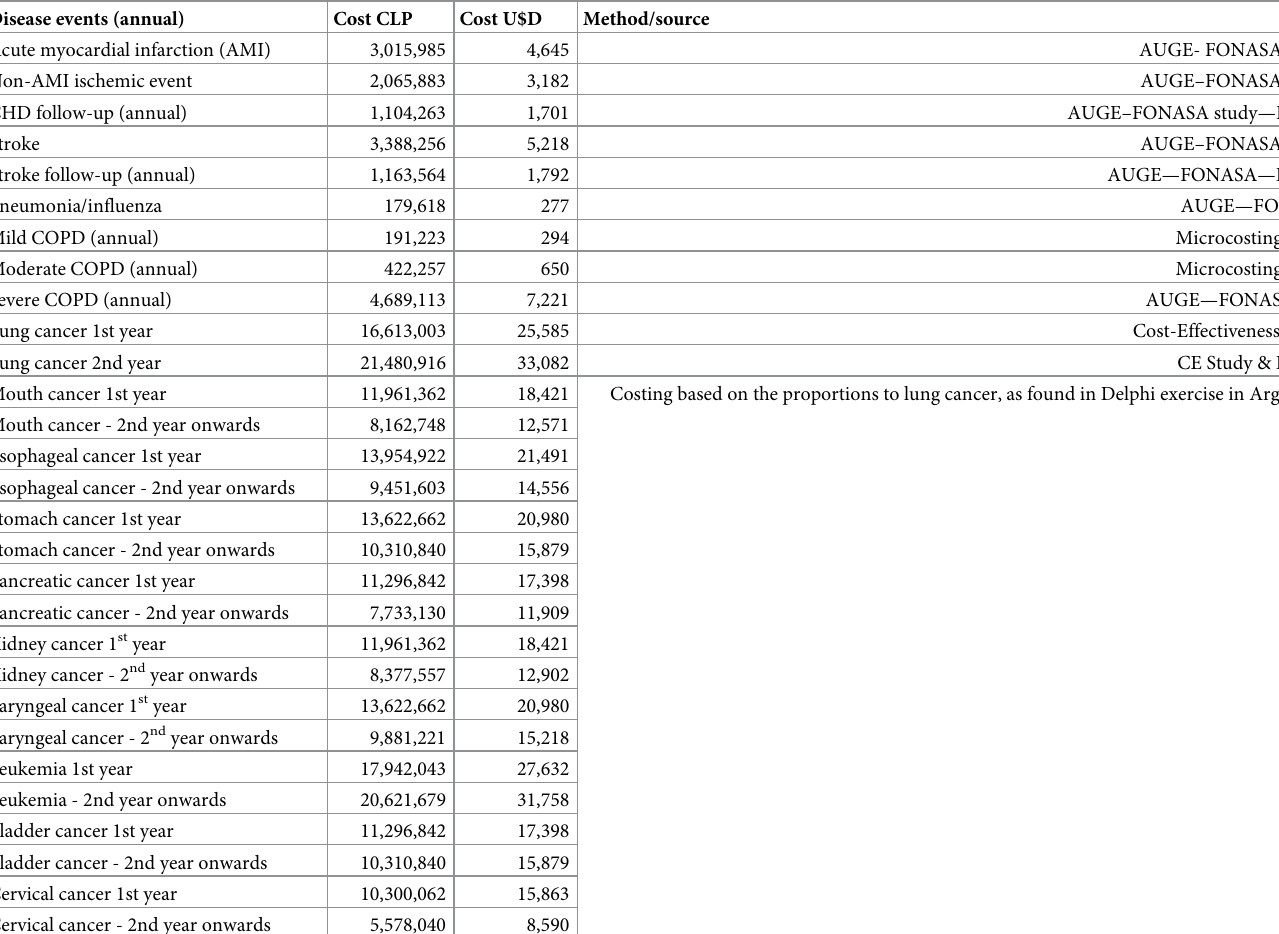
Table 3. Direct medical costs estimated in CLP of December 2017 and U$D � .